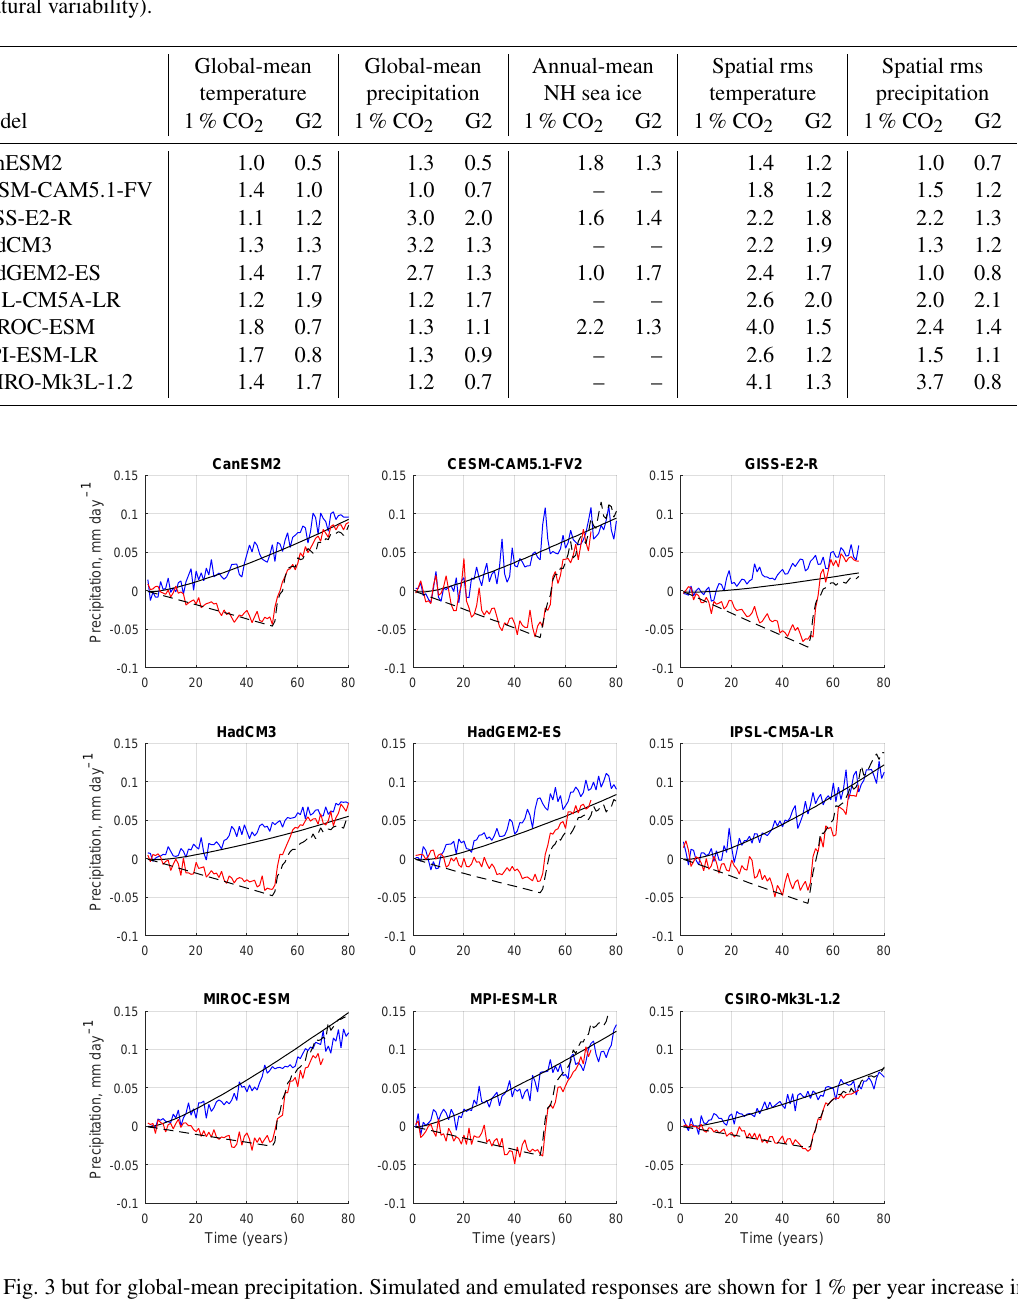
Figure 4. As in Fig. 3 but for global-mean precipitation. Simulated and emulated responses are shown for 1% per year increase in CO 2 and GeoMIP experiment G2 for each of the climate models considered